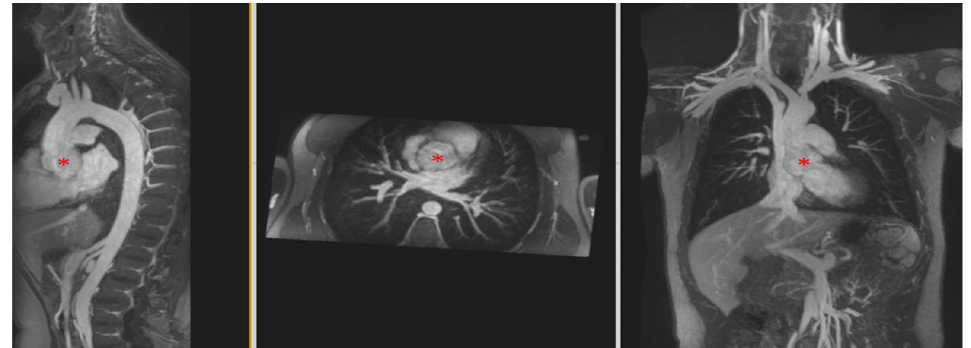
Figure 5. Aortic Root Aneurysm in Marfan Syndrome. Multiplanar reformatted breath-held FE-MRA (sagittal, axial, and coronal planes) in an adult patient with Marfan syndrome depicting an aneurysm of the aortic root (red asterisks). Additionally, homogeneous and high-resolution 3D images of the ascending, transverse (arch), descending thoracic, and upper abdominal aorta were possible in the same acquisition without the need for bolus timing.